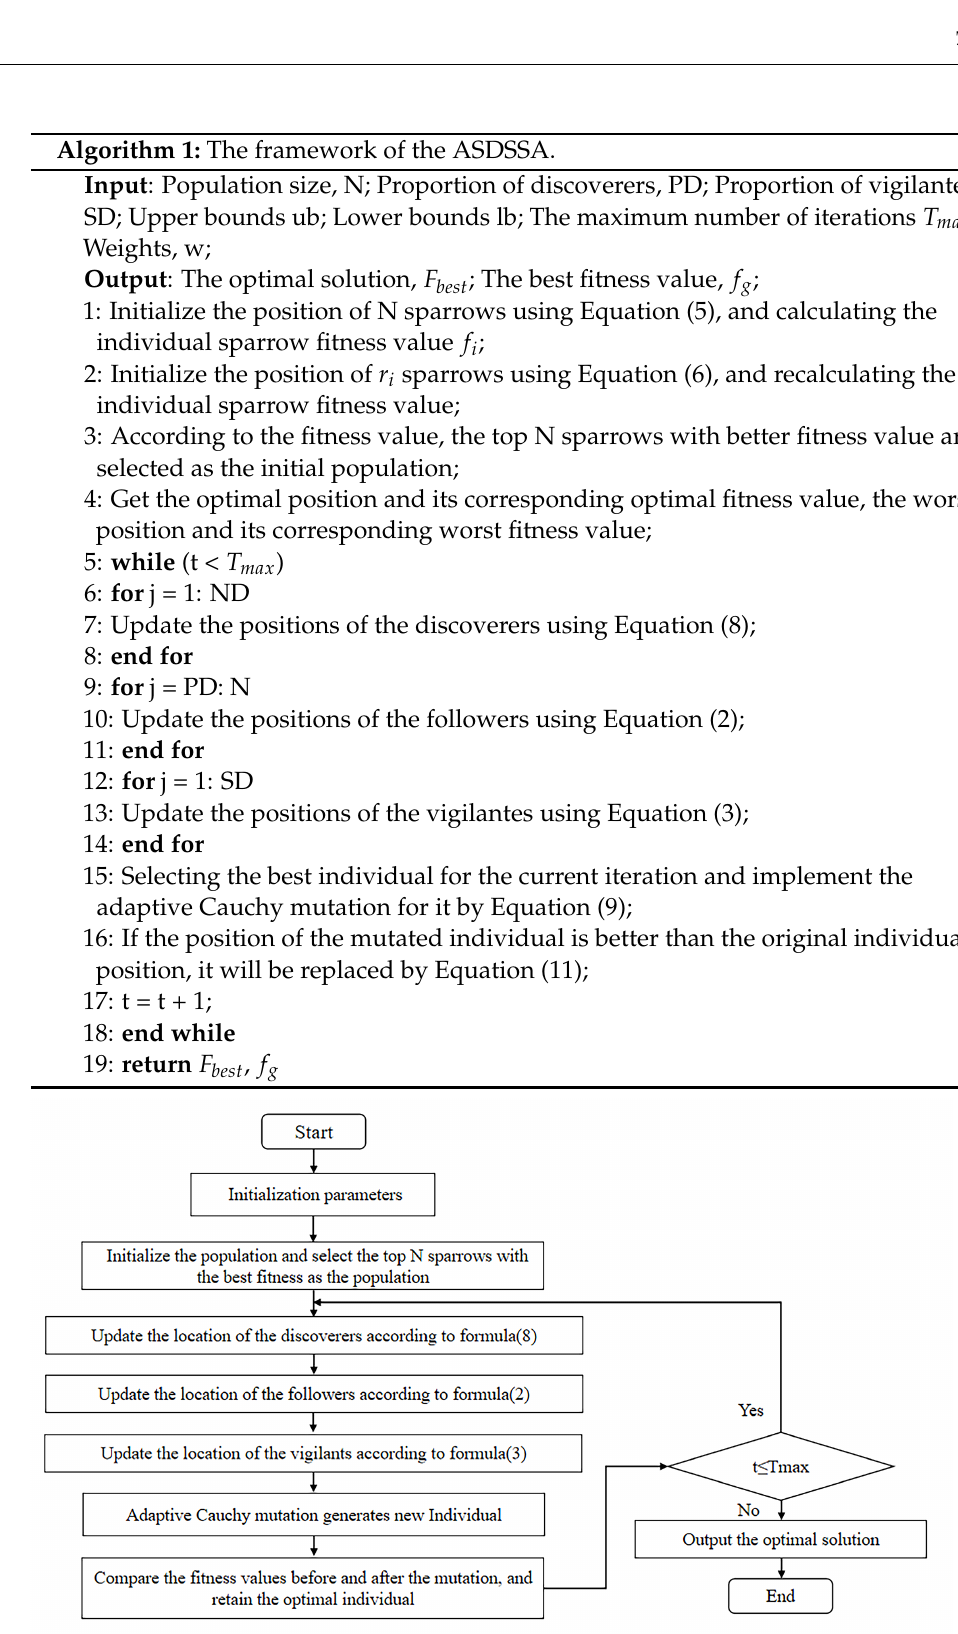
Figure 2. The flowchart of